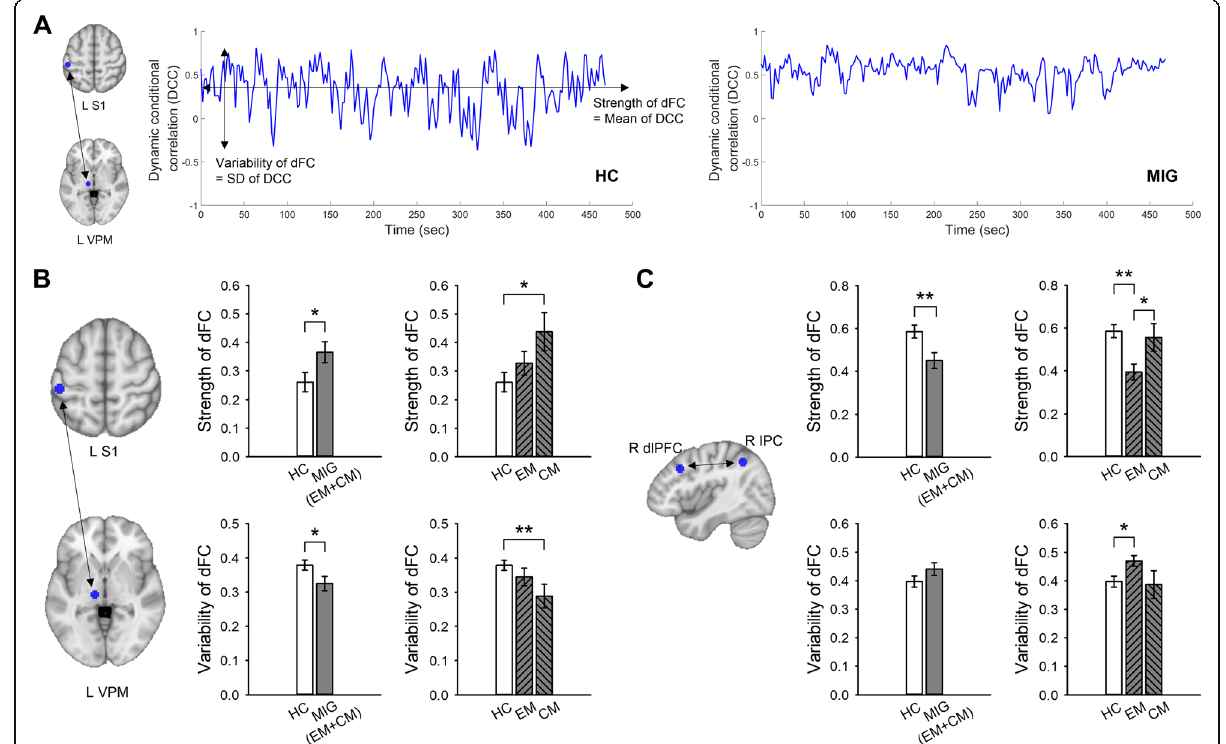
Fig. 4 Example of dynamic conditional correlation between the ventral posteromedial thalamic nucleus (VPM) and primary somatosensory cortex (S1), which have been filtered at 0.01 – 0.198 Hz ( a ) and group differences of dynamic functional connectivity (dFC) in the thalamocortical ( b ) and frontoparietal pathways ( c ). The strength and variability of dFC were derived by the mean and standard deviation of the DCC over time, respectively. Bar graphs of dFC strength and variability were expressed as mean ± SEM. Gray squares/bars represent MIG patients (n = 20) and white squares/bars represent HC subjects (n = 26). MIG patients were divided into EM (n = 13) or CM (n = 7) group for further subgroup comparison. * p < 0.05 and ** p < 0.01 for unpaired t -test. L, left; R, right; dlPFC, dorsolateral prefrontal cortex; IPC, inferior parietal cortex; HC, healthy control; MIG, migraine; EM, episodic migraine; CM, chronic